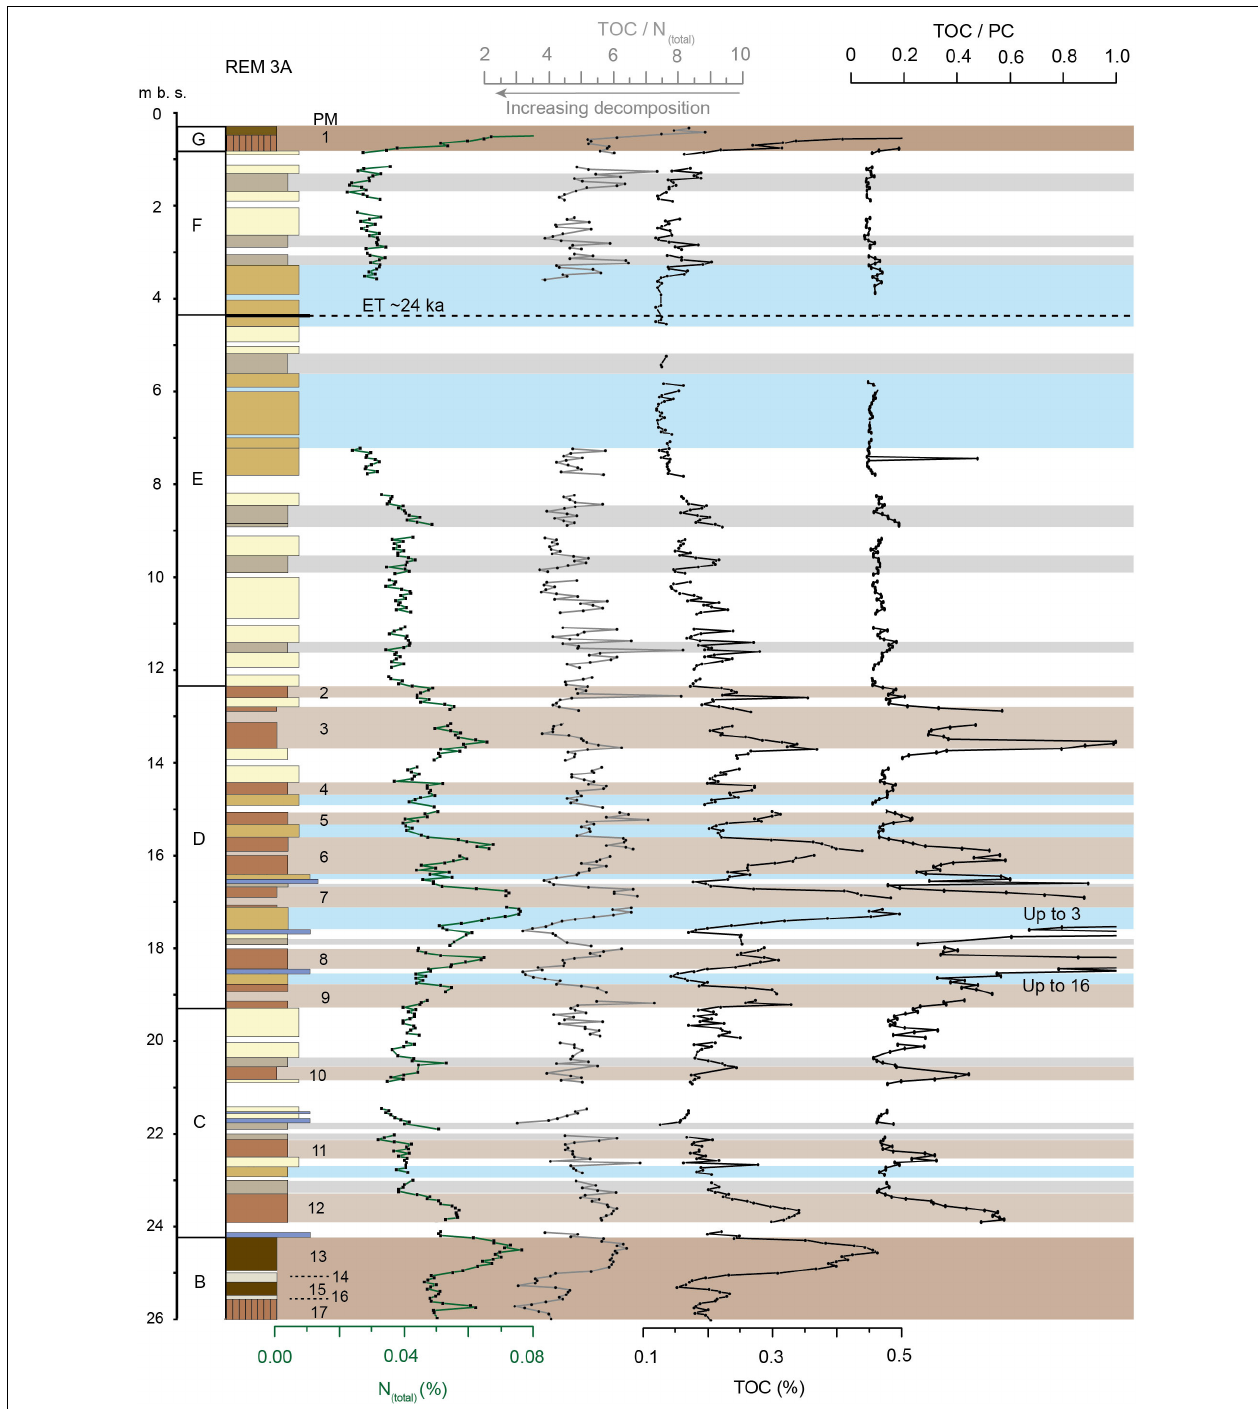
FIGURE 6 | Nitrogen (N ( Total ) ), total organic carbon (TOC), and their ratio (TOC/ N ( Total ) ) as well as the ratio of organic carbon and primary carbonates (TOC/PC) interpreted as ecological Proxies reflecting climate variability and decomposition. Values below error ranges are not depicted. Error ranges: Total N = 0.017%, TOC = 0.122%. Gelic Gleysols are indicated by grey bars, Calcaric Cambisols by light brown bars and soil horizons associated with interglacial and early glacial conditions are represented by dark brown bars. Note that the lowermost part of unit (B) and the entire Holocene topsoil (A) are decalcified. Thus, no values are depicted. Estimated age of the Eltville-Tephra according to Zens et al. (2017) and Förster et al. (2020). Litho- and pedostratigraphic legend according to Figure 3 .